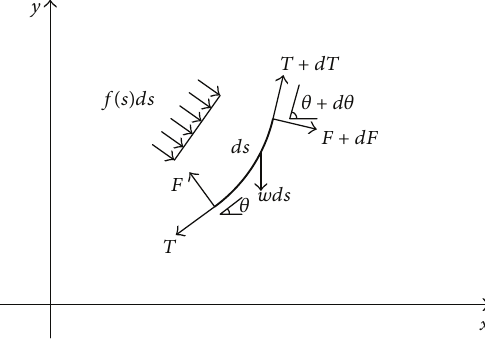
Figure 3: Force analysis of a short pipeline segment.